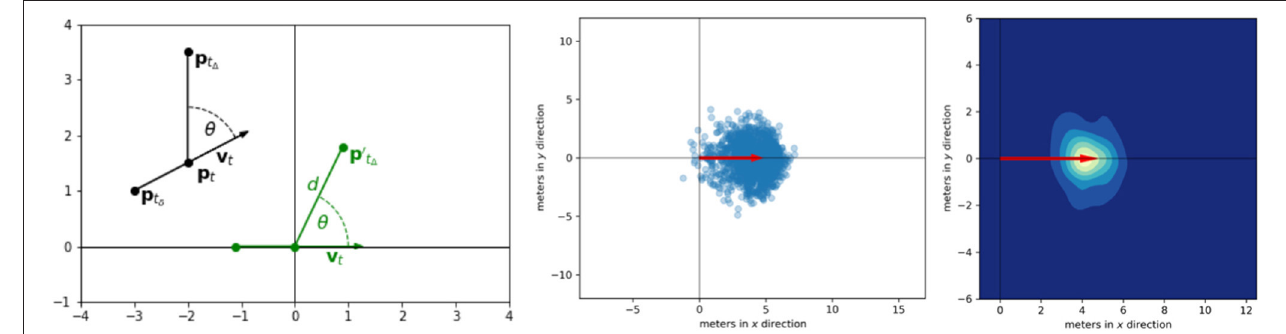
FIGURE 3 | Data-driven movement models. (Left) The initial position p t is mapped to the origin such that the initial direction of movement v t follows the x-axis. Position p t 1 marks the end of the trajectory. Position p t δ is required to estimate initial velocity. (Center) Resulting point cloud. (Right) Smoothed movement model using density estimation.